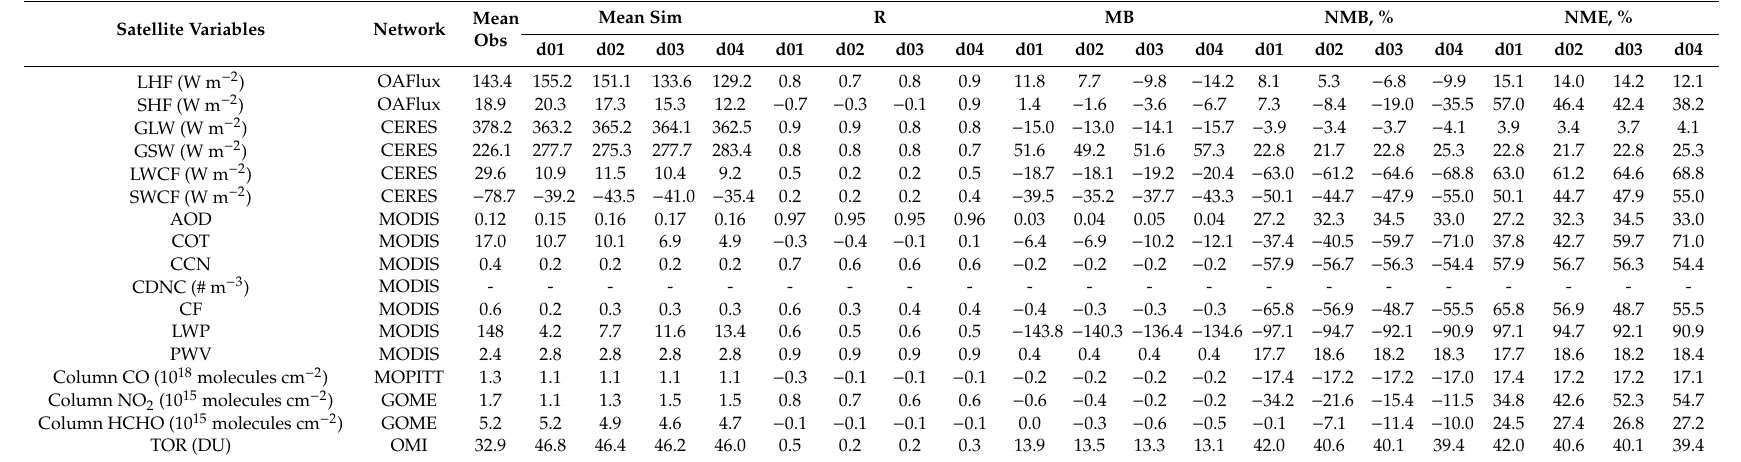
Table 6. Performance statistics of radiative, cloud, heat flux, and column gas variables from WRF / Chem-ROMS simulations at a horizontal grid resolution of 81-km (in d01), 27-km (in d02), 9-km (in d03), and 3-km (in d04) calculated using predictions and observations in d04 over the 3-km domain (d04) for the MUMBA field